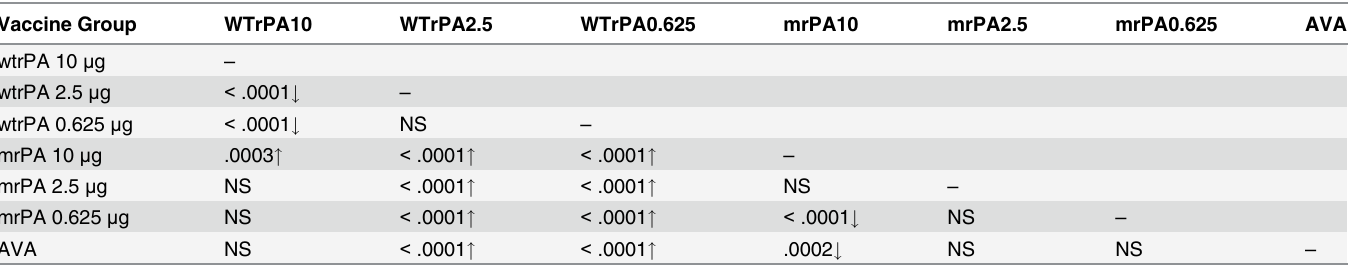
TNA ED 50 values from blood draws between day -1 and 65 were analyzed by repeated measures ANOVA. The ED 50 response of non-vaccinated groups (None and Vehicle, not shown) were signi fi cantly lower (p < 0.0001) than every other group except each other. # Indicates the ED 50 response of the vaccine group listed on the left is less than the corresponding vaccine group listed on the top of the table. " Indicates the ED 50 response of the vaccine group listed on the left is greater than the corresponding vaccine group listed on the top of the table. NS, no statistical signi fi cance between the reactions of the two